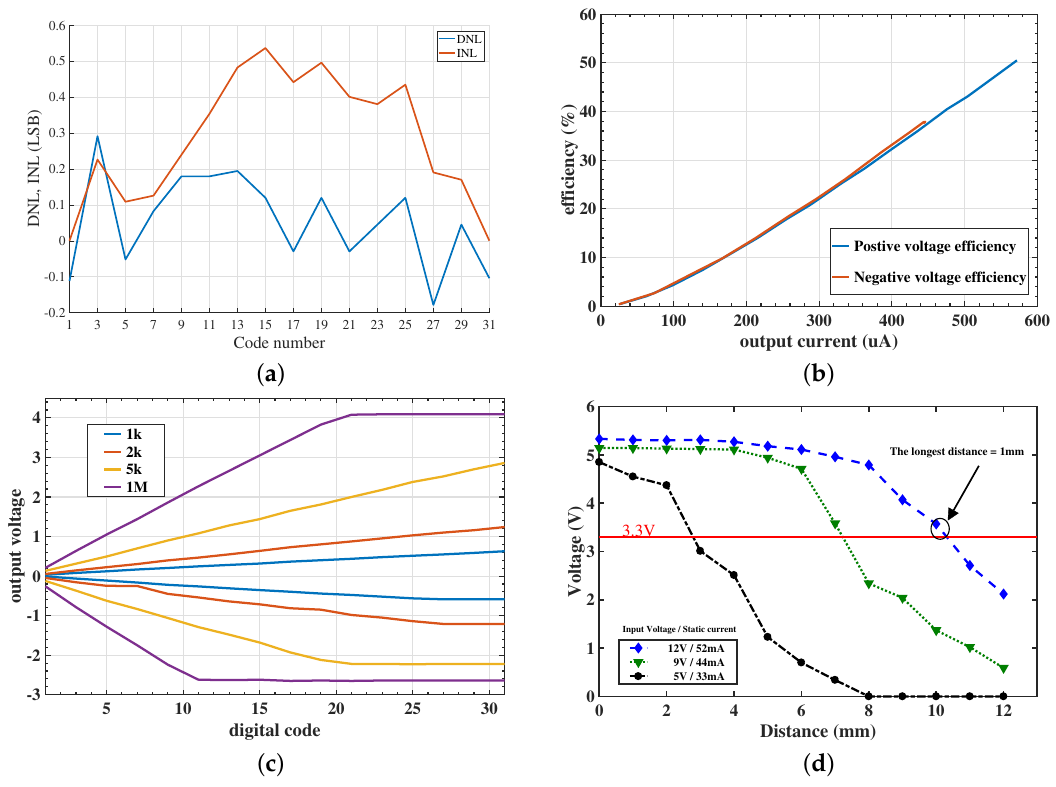
Figure 11. ( a ) Measured Differential Non-Linearity (DNL) and Integral Non-Linearity (INL) of the current DAC. The highest integral non-linearity of less than 0.6 LSB and differential non-linearity of less than 0.3 LSB are achieved. ( b ) The efficiency of a single channel stimulator. The result obtained under the load of 5 k Ω for different output currents. ( c ) The output current versus digital code. The positive voltage will saturate to the power rail, and the negative voltage saturation level will be determined by the charge pump. ( d ) The output voltage of the receiver end for different distances between the transmitter and receiver coils, as indicated on the horizontal